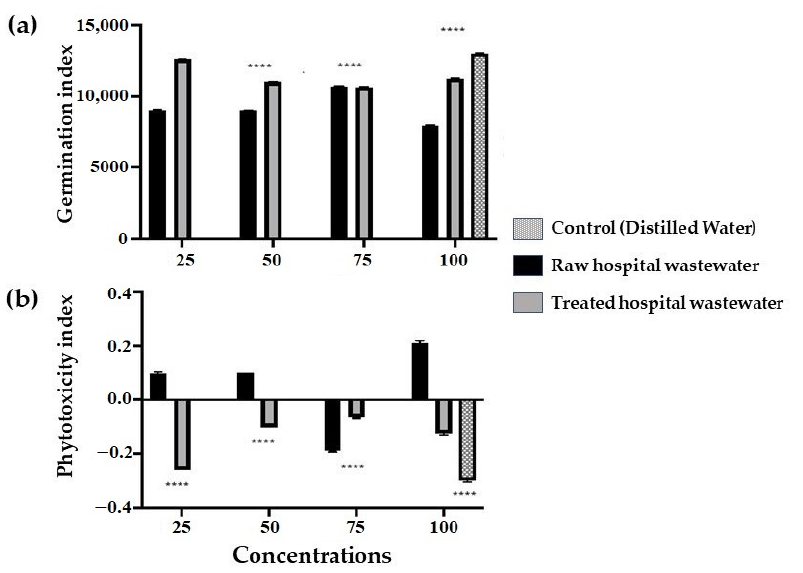
Figure 8. ( a ) Germination indices of Wheat seeds grown in untreated and treated hospital wastewaters; ( b ) Phytotoxicity indices of Wheat seeds grown in untreated and treated hospital wastewaters. Significance (Welch’s test) between treated and untreated hospital wastewater is indicated by p < 0.0001 ****.